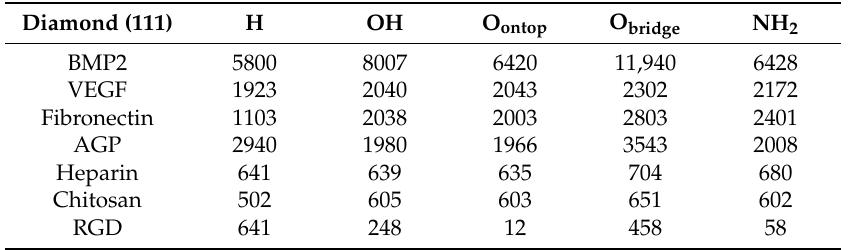
Table 3. Adhesion energy for various biomolecules attached onto an X-terminated diamond (111) surface (X = H, OH, O ontop , O bridge and NH 2 ). The biomolecules include VEGF, BMP2, AGP1, fibronectin, heparin, chitosan and RGD. The unit is kJ/mol. Diamond (111) H OH O